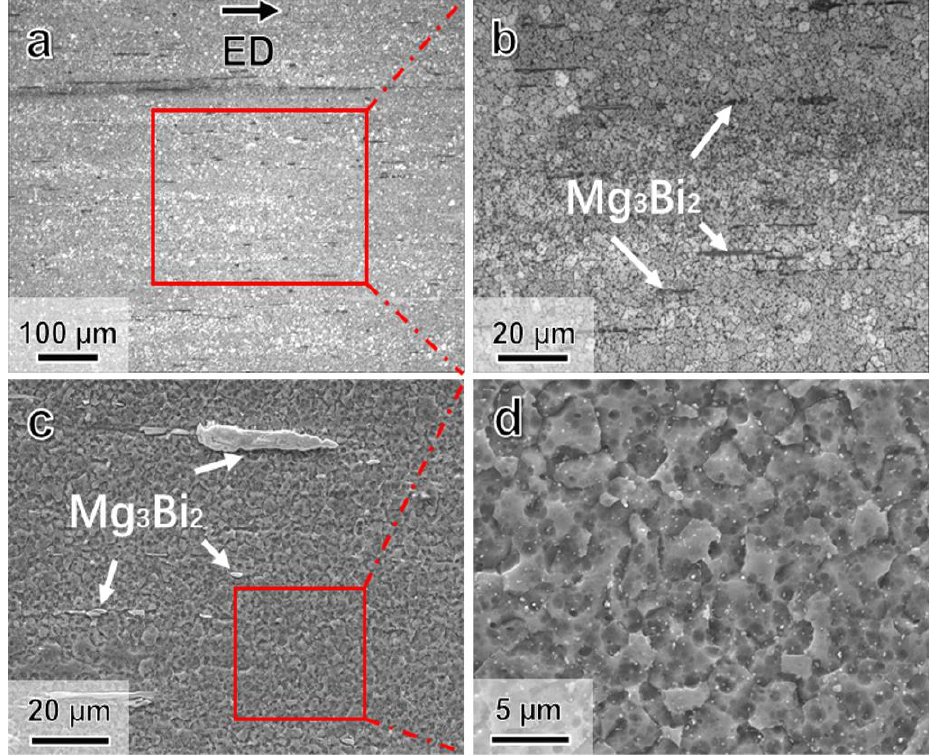
Figure 3. OM ( a , b ) and SEM ( c , d ) micrographs of as-extruded BAZ631 alloy; ED: extrusion direction. In order to elucidate the precipitation behavior of BAZ631 alloy during extrusion, TEM characterization was conducted, and the corresponding results are presented in Figure 4. Both micro-scale second phase and ultra-fine precipitates dispersed in the fine DRXed matrix, which well agreed with the OM and SEM observations. The most distinctive feature of the TEM microstructures is that abundant nano-scale globular particles with a size varying from 50–200 nm are distributed both at grain boundaries (GBs) and within grain interiors. Most of the nano-scale particles were further identified as Mg 3 Bi 2 by the selected area diffraction pattern (SADP) (Figure 4d). In addition, some fine Mg 17 Al 12 precipitates were also identified according to the results of SADP in Figure 4e, which is quite different with the as-extruded BAZ811 alloy only containing Mg 3 Bi 2 precipitates. The distribution of these fine Mg 3 Bi 2 particles both at GBs and within grain interiors indicates that dynamic precipitation occurred during high-speed extrusion at 300 ◦ C, which is well agreed with recent research on low-speed extruded Mg-Bi binary alloys [7,8] and high-speed extruded Mg-Bi-Al alloy [18,19]. As a typical precipitation-hardenable Mg alloy system, the solubility of Bi in Mg at the homogenization treatment temperature (450 ◦ C) in this study